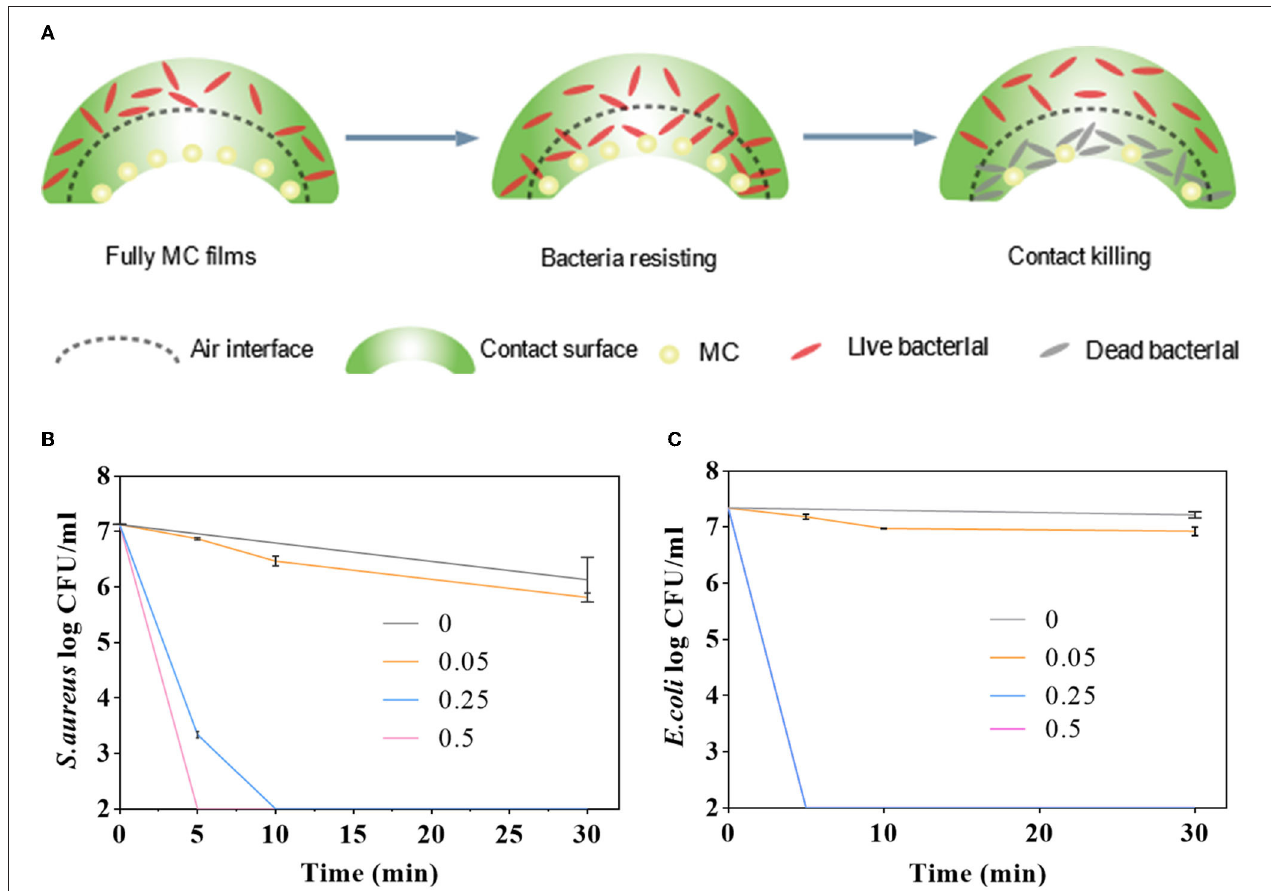
FIGURE 5 | (A) Diagrammatic sketch of antibacterial mechanism of the as-synthesized MC-containing polylactic acid films; antimicrobial activities of the control films (PLA film), PLA–MC-0.05, PLA–MC-0.25, and PLA–MC-0.5 films against (B) S. aureus and (C) E. coli ,